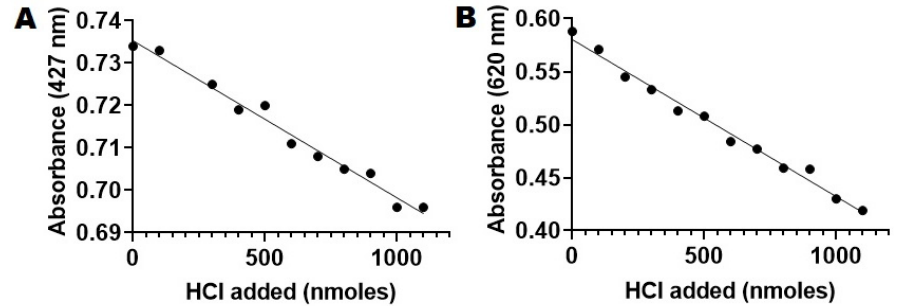
Figure 4. ( A ). Absorbance of BTB (0.05 mM working concentration) as a function of the amount of HCl added at 427 nm. ( B ). Absorbance of BTB (0.05 mM working concentration) as a function of the amount of HCl added at 620 nm.